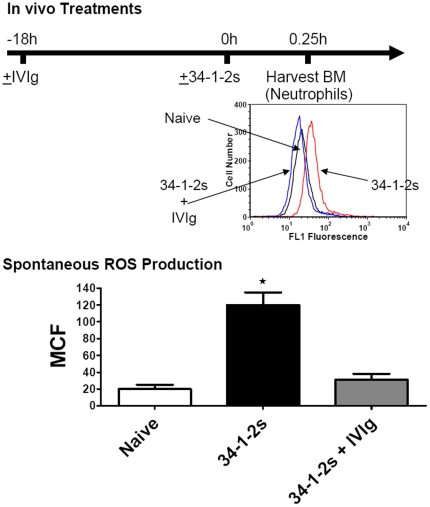
IVIg prevents spontaneous ROS production in SCID mice.The effect of the indicated in vivo treatments on spontaneous ROS production. SCID mice were either not treated (Naïve) or treated with 2 g/kg IVIg and/or 2 mg/kg 34-1-2s and their neutrophils were purified from bone marrow and tested for their ability to produce ROS spontaneously in vitro. Results are expressed as mean channel fluorescence of DHR-123 fluorescence (±SEM) from 10 mice per group. The time line at the top demonstrates the protocol timing and the insert graph shows a typical histogram analysis of spontaneous DHR-123 fluorescence in the 3 indicated mouse groups. The ★ indicates significance (p<0.05) between naïve mice and the other groups of mice determined by Student's t test.